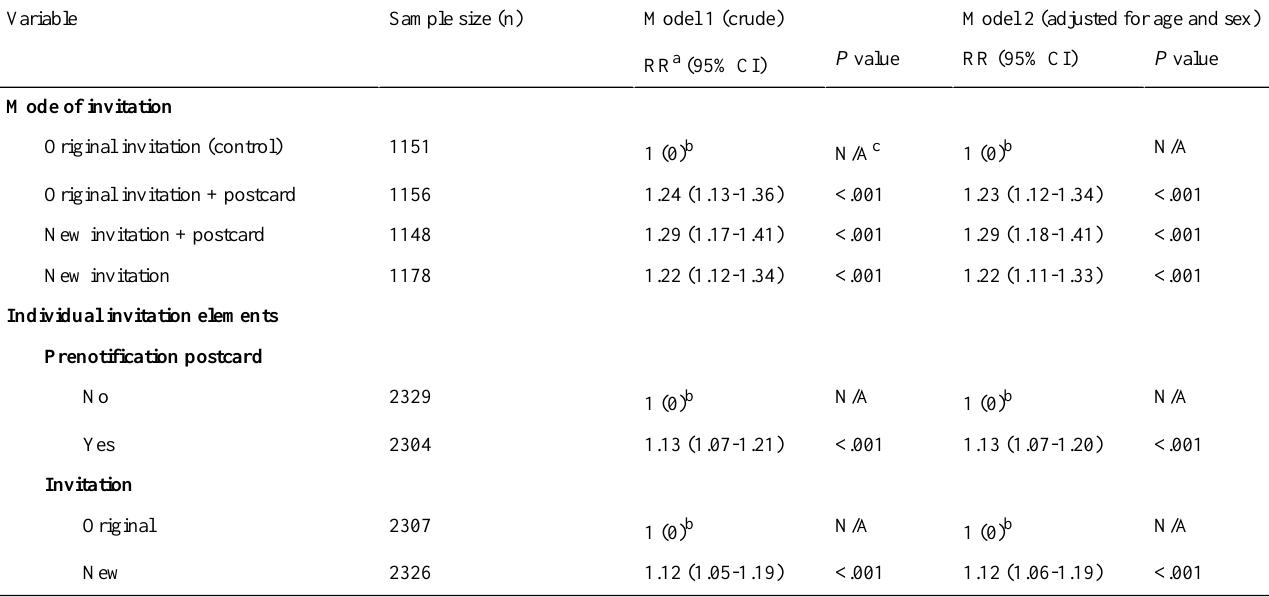
Table 2. Analysis of associations between participation, mode of invitation, and invitation elements among patients invited to take part in a preventive primary care program for lifestyle-related diseases (TOF